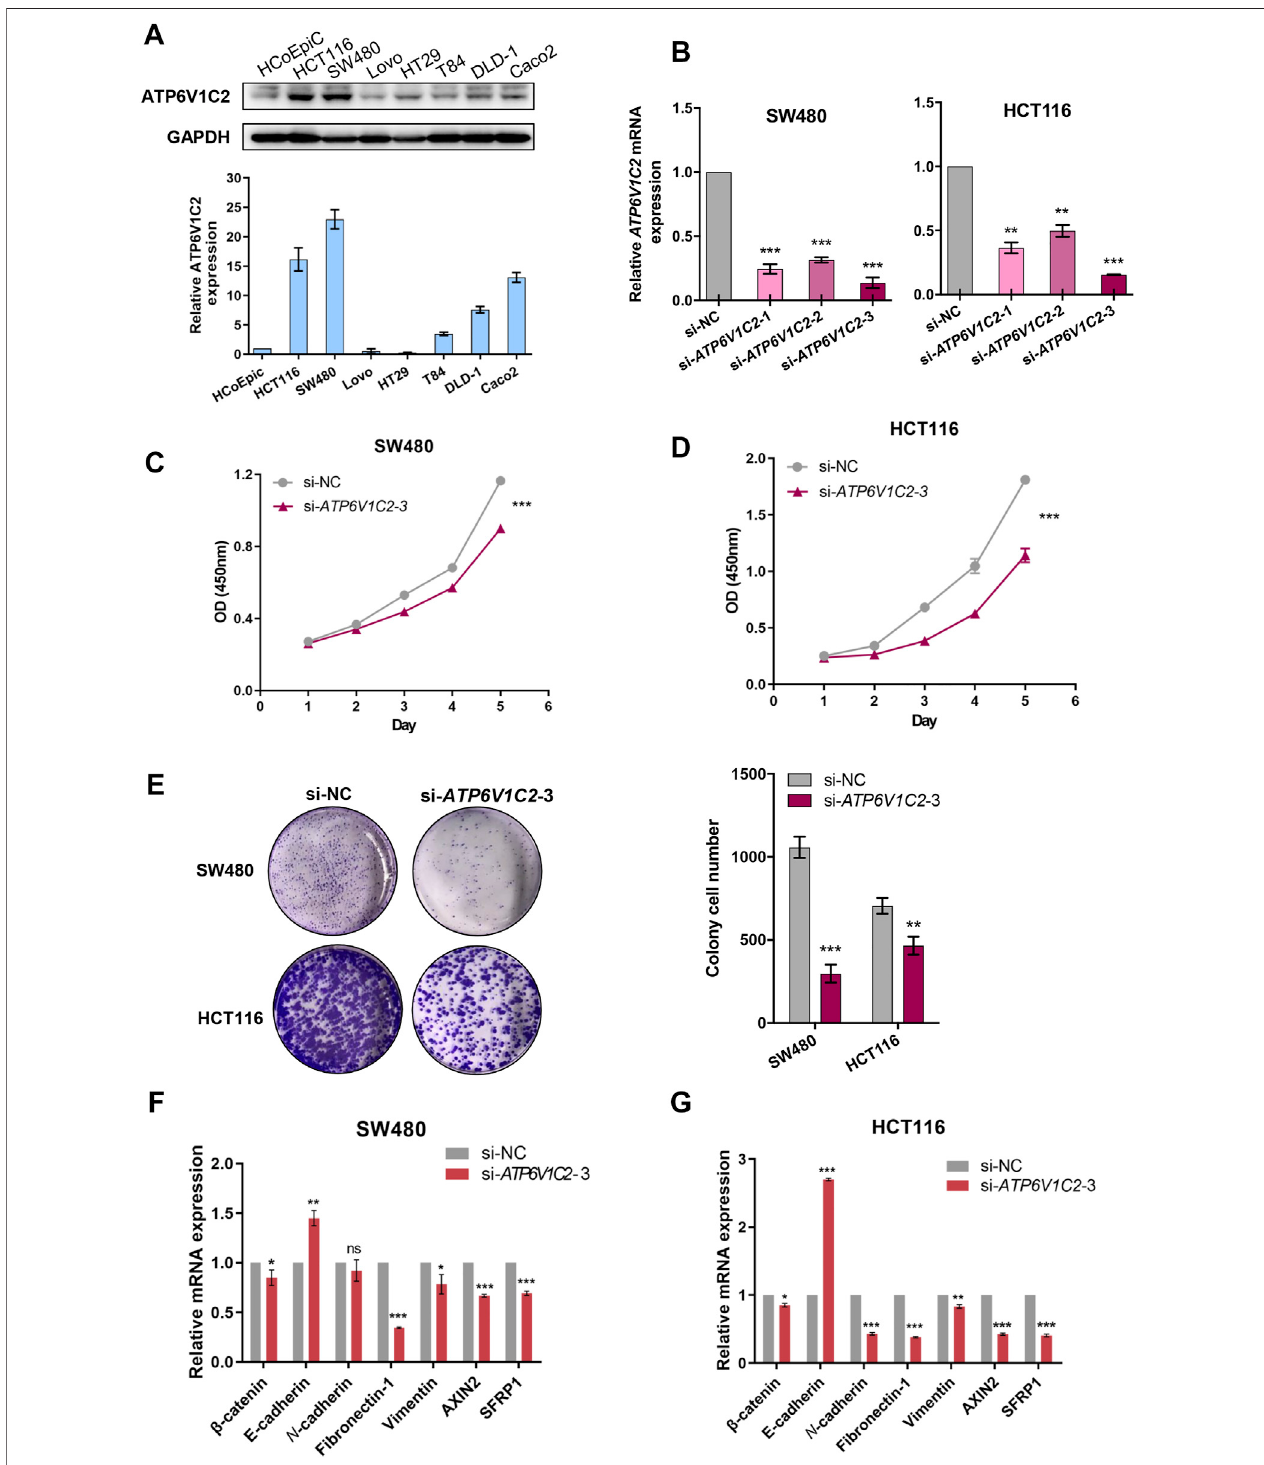
FIGURE 7 | In vitro studies on ATP6V1C2 in COAD tumorigenesis. (A) The protein expression level of ATP6V1C2 in human colonic epithelial cells (HCoEpiC) and COAD cells; (B) The mRNA expression level of ATP6V1C2 in SW480/HCT116 cells transfected with siATP6V1C2 and siNC; (C) Proliferation curves assessed by CCK8 assay during 120 h for ATP6V1C2 knockdown cell model of SW480; (D) Proliferation curves assessed by CCK8 assay during 120 h for ATP6V1C2 knockdown cell model of HCT116; (E) The cloning ability for ATP6V1C2 knockdown cell models of SW480 and HCT116; The expression level of Wnt pathway-related and EMT-related genes in SW480 (F) and HCT116 cells (G) with siATP6V1C2. COAD: colon adenocarcinoma. *, **, and *** indicate p < 0.05, p < 0.01, and p < 0.001, respectively. OD: optical density; NC: normal control.